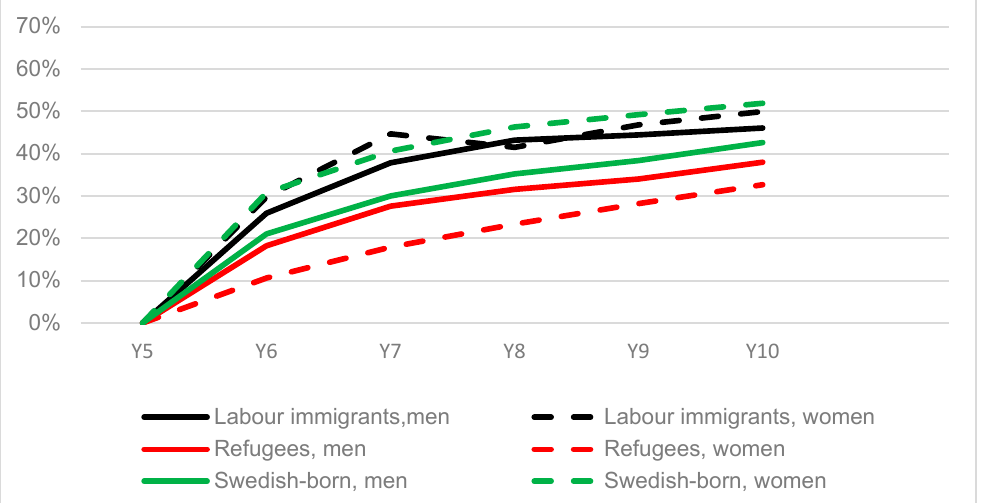
Figure 2. The proportion with an income of 1.75 PBA or more from paid work (self-sufficiency) at year 6–10 for the shares of labour immigrants, refugees and Swedish-born that earned 1.75 PBA 1 at year 5 after receiving a residence permit 2 (stratified by sex, n = 127 133). 1 Price base amount, an annual figure, e.g., benefits taking into account inflation; 2 Year of residence permit = year 0. Swedish-born were given a fictive “year 0” 2000–2006 and were matched by age and sex; approx. 5 Swedish-born to each immigrant.